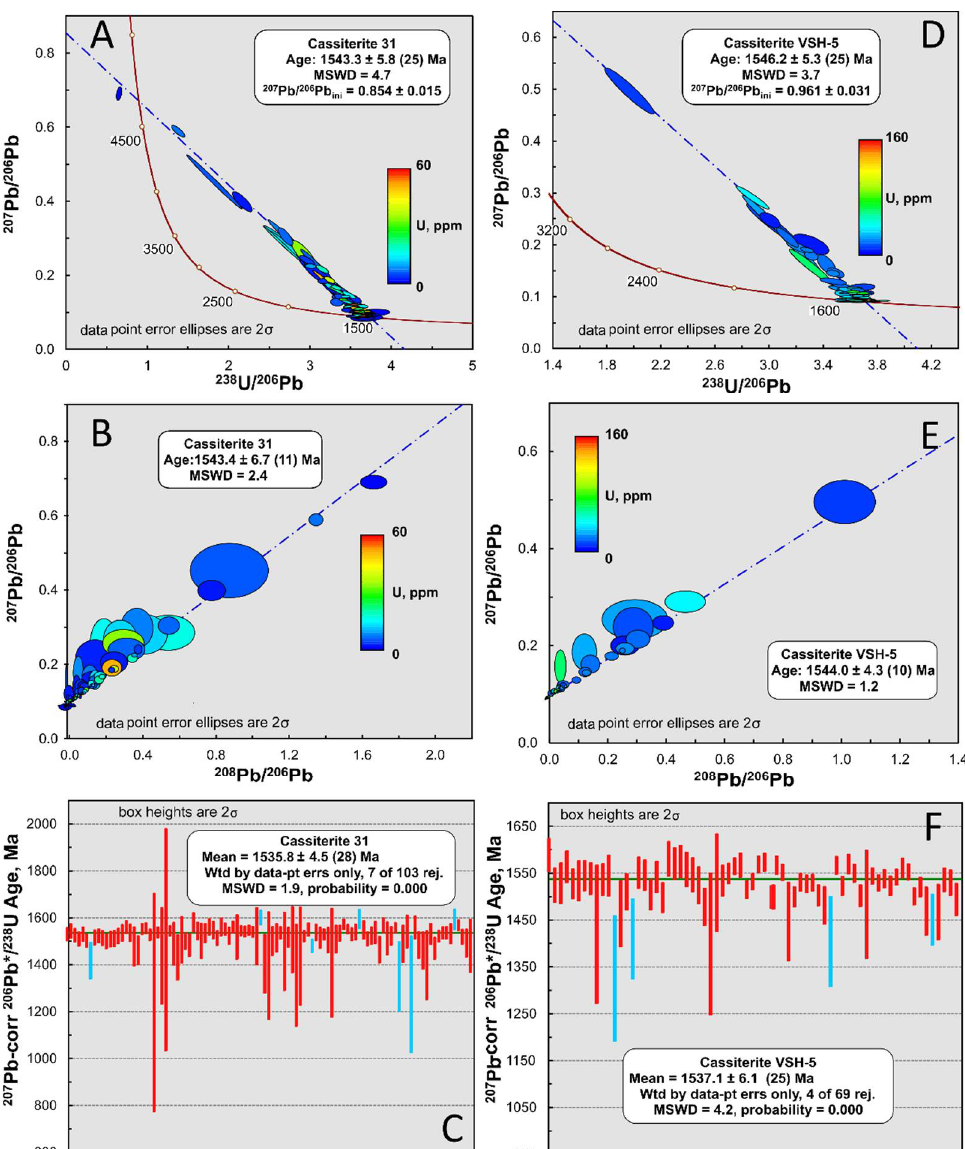
Figure 12. The U-Pb isotope data for cassiterite samples 31 ( A – C ) and VSH-5 ( D – F ) from the Pitkäranta Mining District skarn deposits. Tera-Wasserburg isochron diagrams ( A , D ), inverse Pb-Pb isochrons ( B , E ) and weighted averages of the 207 Pb-corrected 206 Pb*/ 238 U ages ( C , F ) are also shown. The vertical lines in ( C , F ) represent age values with 2 standard error (2 SE) bars. The blue lines are outliers not included in the weighted average calculation.